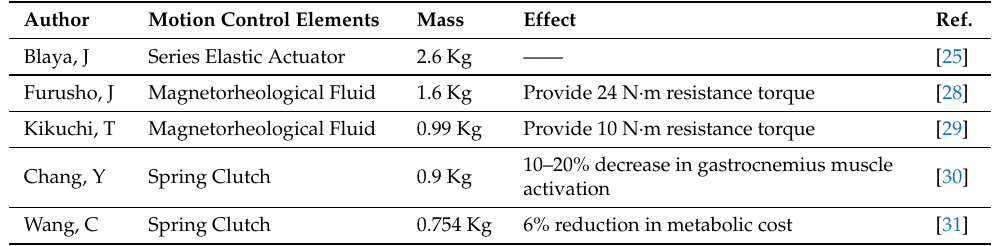
Table 2. Comparison of SAFOs in mass and